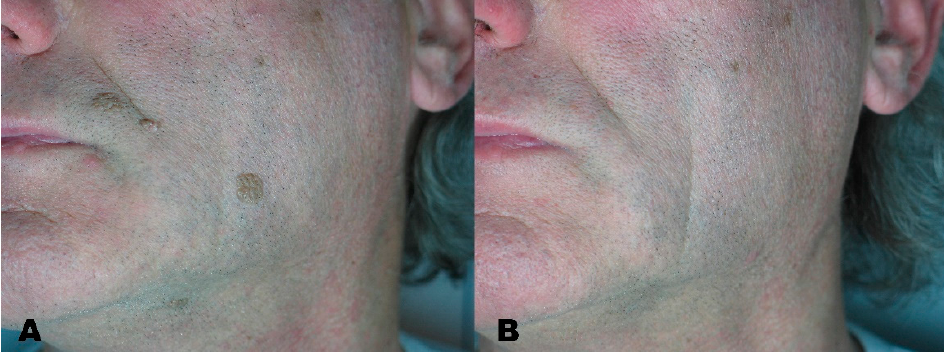
Figure 7. ( A ) Seborrheic keratosis before treatment. ( B ) Region after removal with Erbium laser.